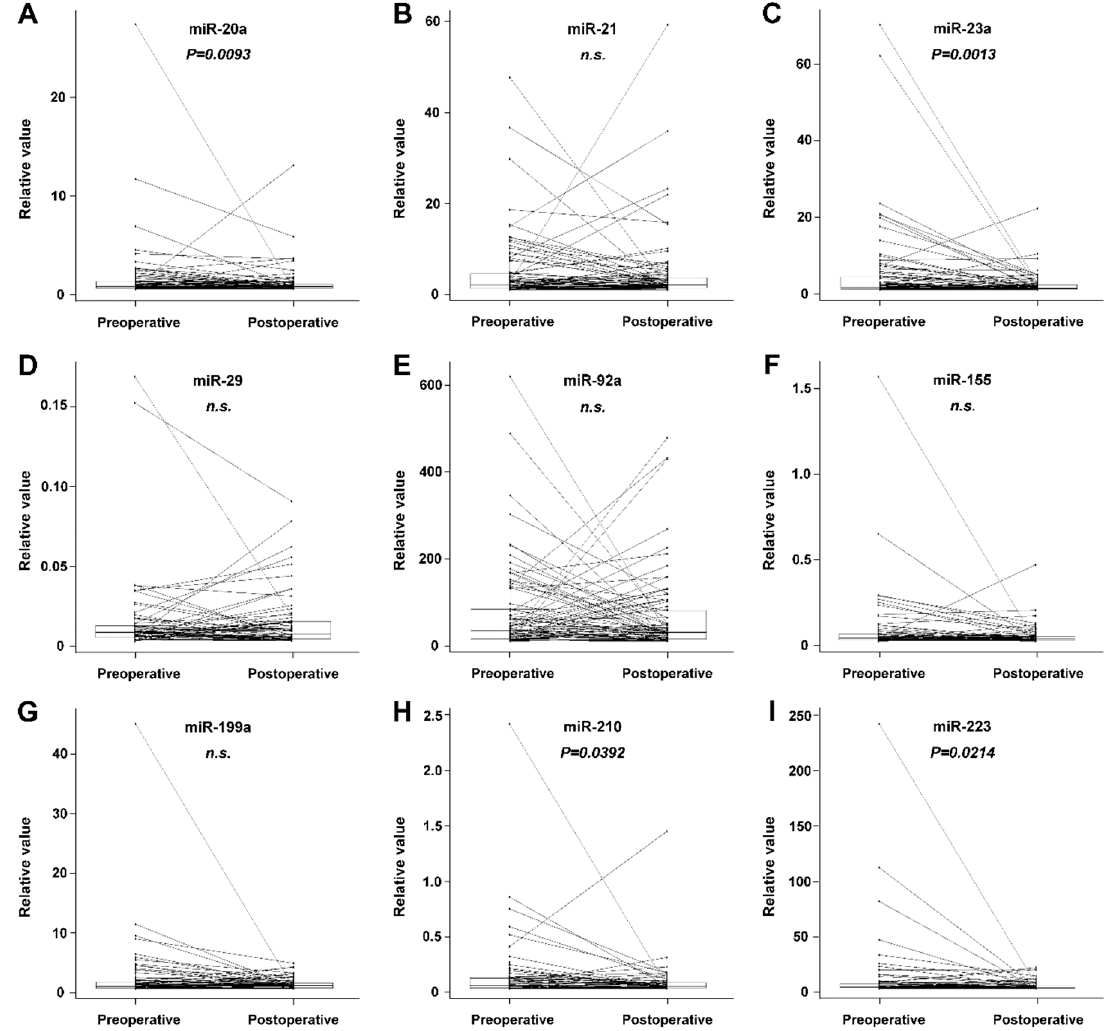
Figure 1. Comparison of paired preoperative and postoperative blood plasma miRNA values in the group comprising all patients. Box-and-whisker plots with outliers shown as separately plotted points. Paired values are connected by a line. A statistically significant decrease was recorded for miR-20a, miR-23a, miR-210, and miR-223. (n.s. = non-significant)